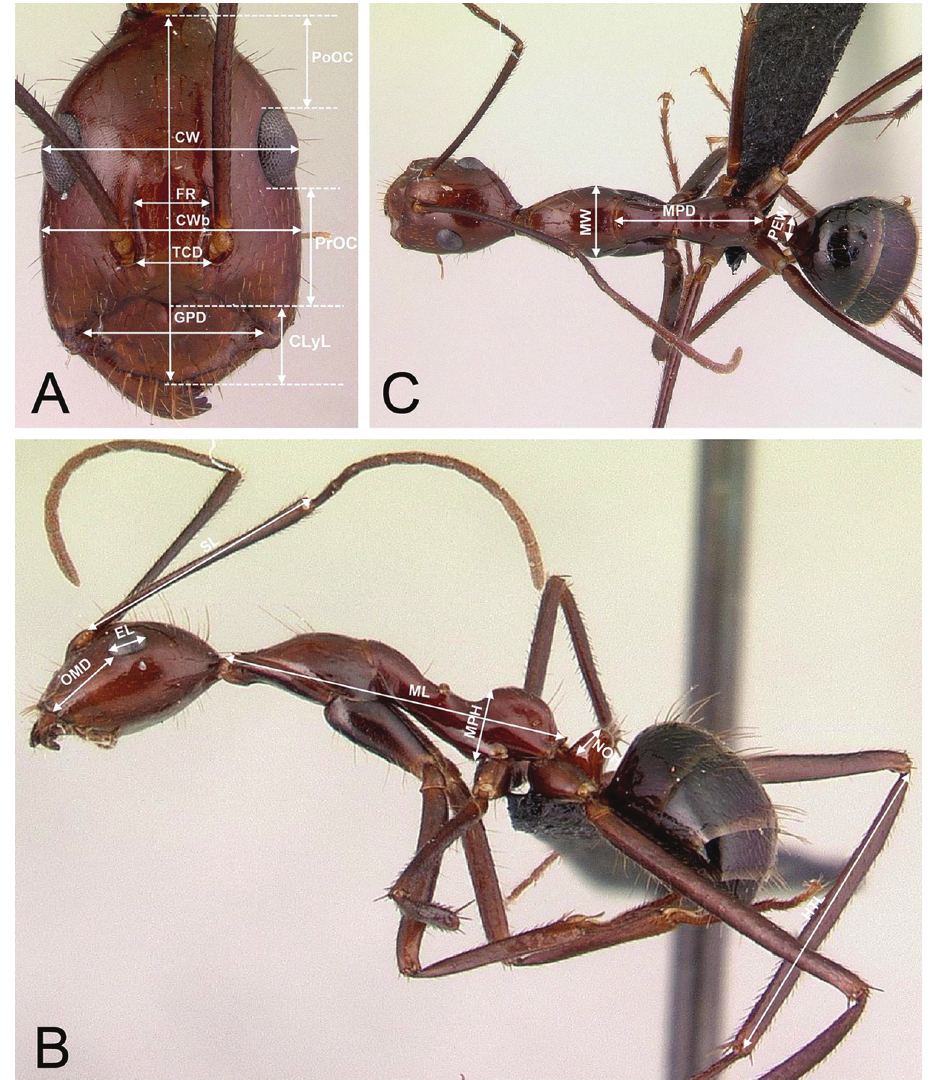
Figure 2. Illustrations of measurements used to distinguish members of Myrmopytia . A Full-face view of the head illustrating measurement lines for maximum cephalic length (CL), clypeal length (ClyL), maximum cephalic width (CW), maximum head capsule width (CWb), eye length (EL), frontal carina distance (FR), maximum tentorial pit distance (GPD), postocular distance (PoOC), preocular distance (PrOC) and torular carina distance (TCD) B Lateral view of the body illustrating measurement lines for oculo-mandibular distance (OMD), scape length (SL), mesosoma length (ML), mesothoracico-propodeal height (MPH), petiolar node height (NOH) and maximum hind tibia length (HTL) C Dorsal view of the body illustrating measurement lines for mesosoma width (MW), mesothoracico-propodeal distance (MPD) and petiolar width